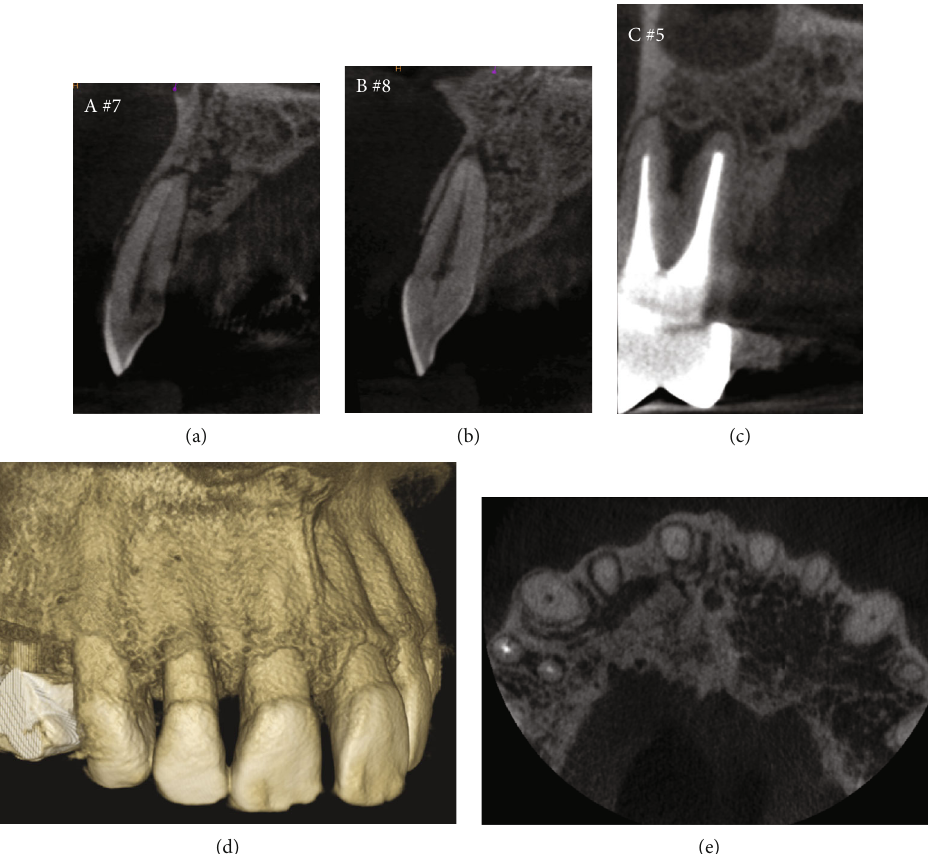
Figure 4: Postoperative CBCT images. CBCT images of the maxillary right central and lateral incisors after a three-year period from the retreatment of only the fi rst premolar; the hypodense regions had almost disappeared (a – c). Volume rendering image after three years showed that the buccal cortical bone had clearly recovered (d). Axial image of maxillary front to premolar area after three years shows the progress of osteoanagenesis in the palatal area